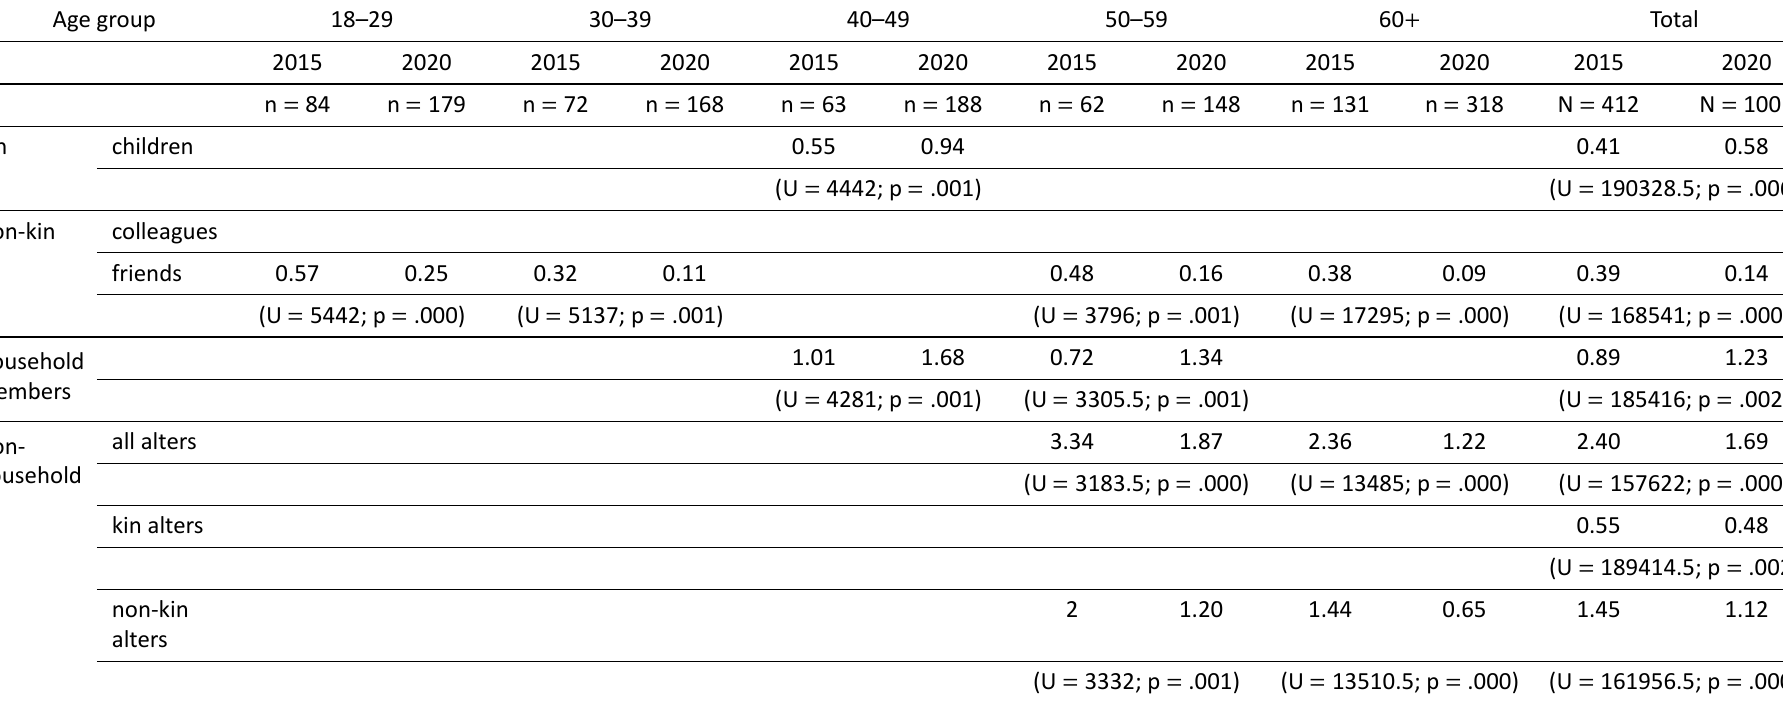
Table 5. Mean number of contacted alters by respondents’ age group and by respondents’ relationship to alters (per day) (with Bonferroni Mann‐Whitney U tests; only significant